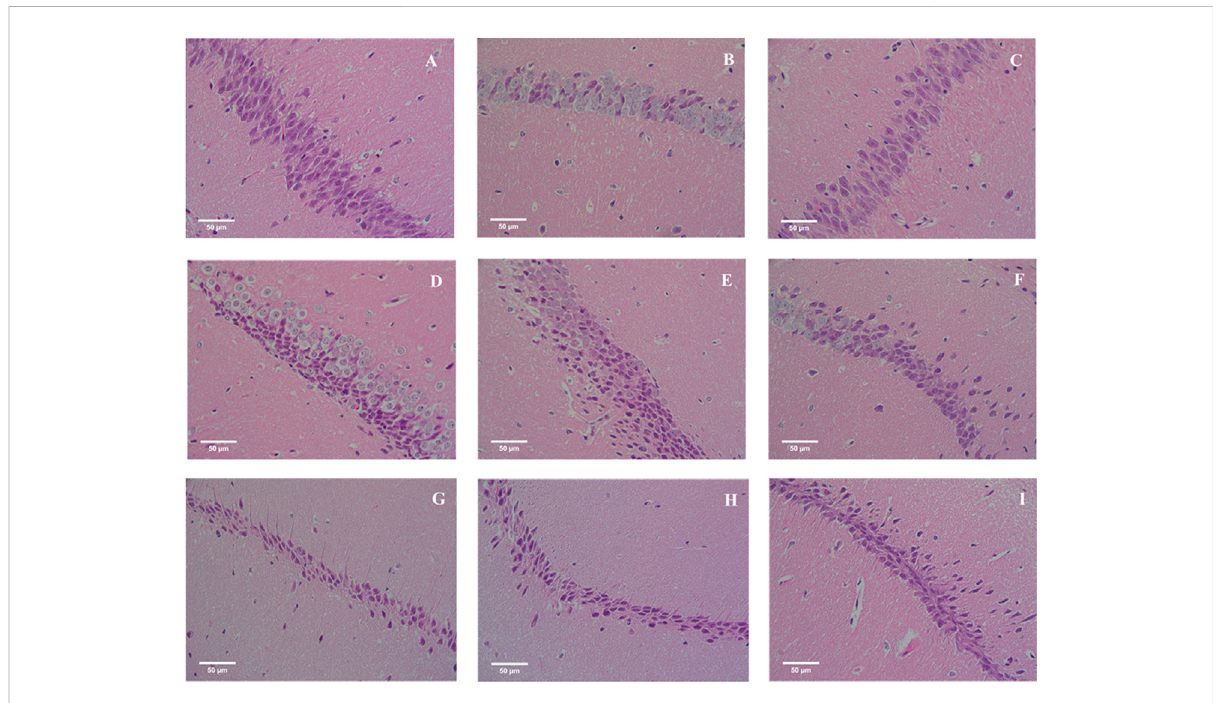
FIGURE 6 Effect of EOC on the hippocampus in mice (HE, original magni fi cation, ×400). (A) CON. (B) MOD. (C) DON. (D) DLI-L. (E) DLI-M. (F) DLI-H. (G) EOC-L. (H) EOC-M. (I)